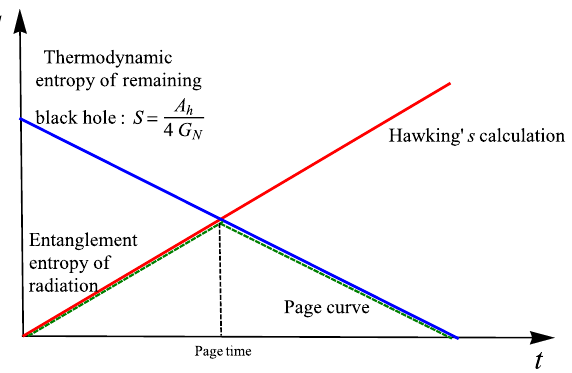
Fig. 2 The Page curve, described by the green dashed line, for the black hole evaporation with the island method